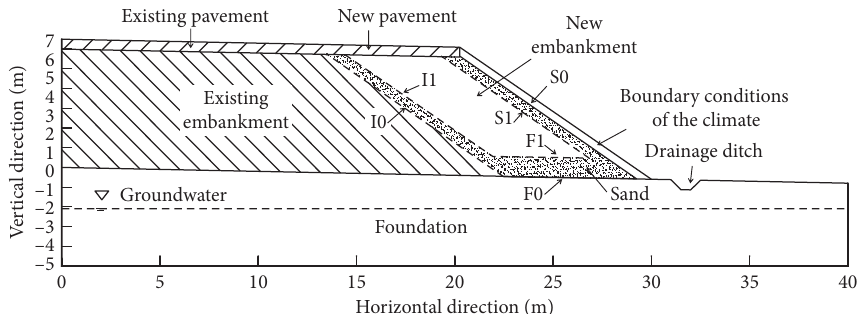
Figure 4: Geometric model of the existing and new